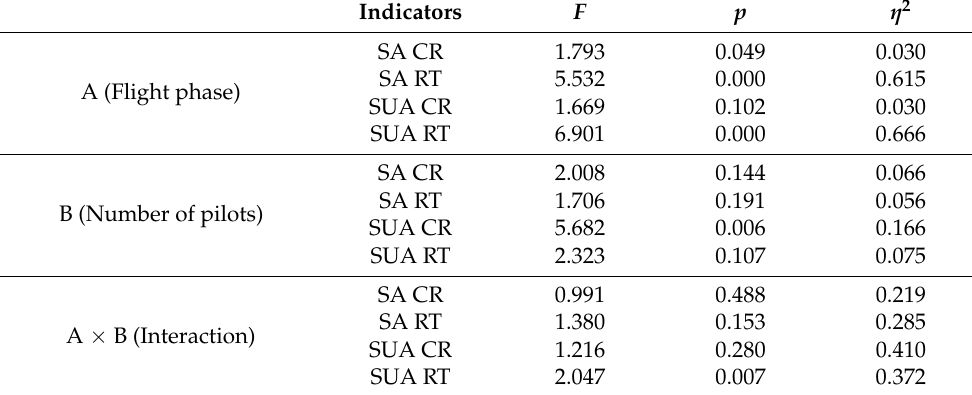
Table 4. Analyze results of the attentional